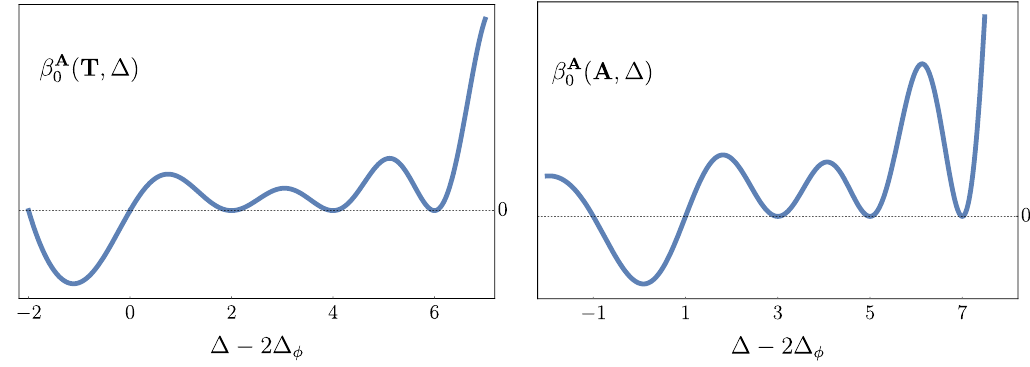
Figure 4 . Bosonic functional β A the T and A channels for ∆ φ = 1 . The action in the S channel is proportional to that in the T